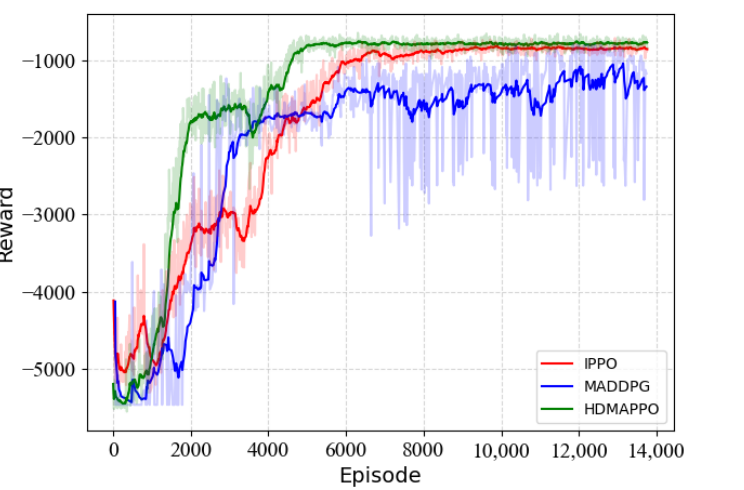
Figure 3. Convergence performance of reinforcement learning-based offloading